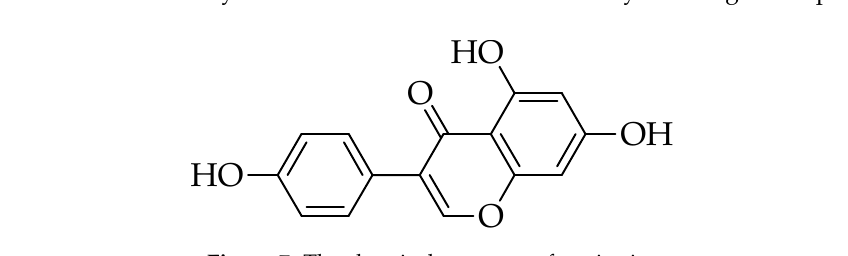
Figure 7. The chemical structure of genistein.